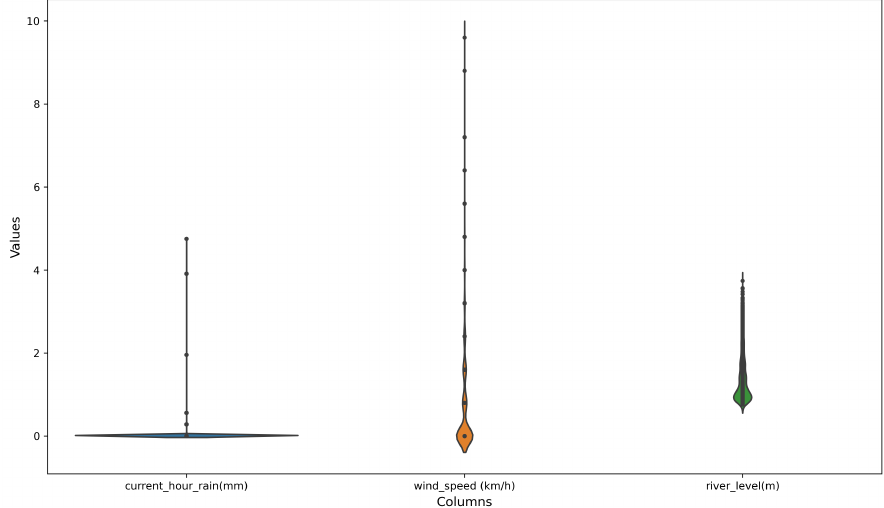
Figure 18. Histograms of the selected continues variables for the time given.